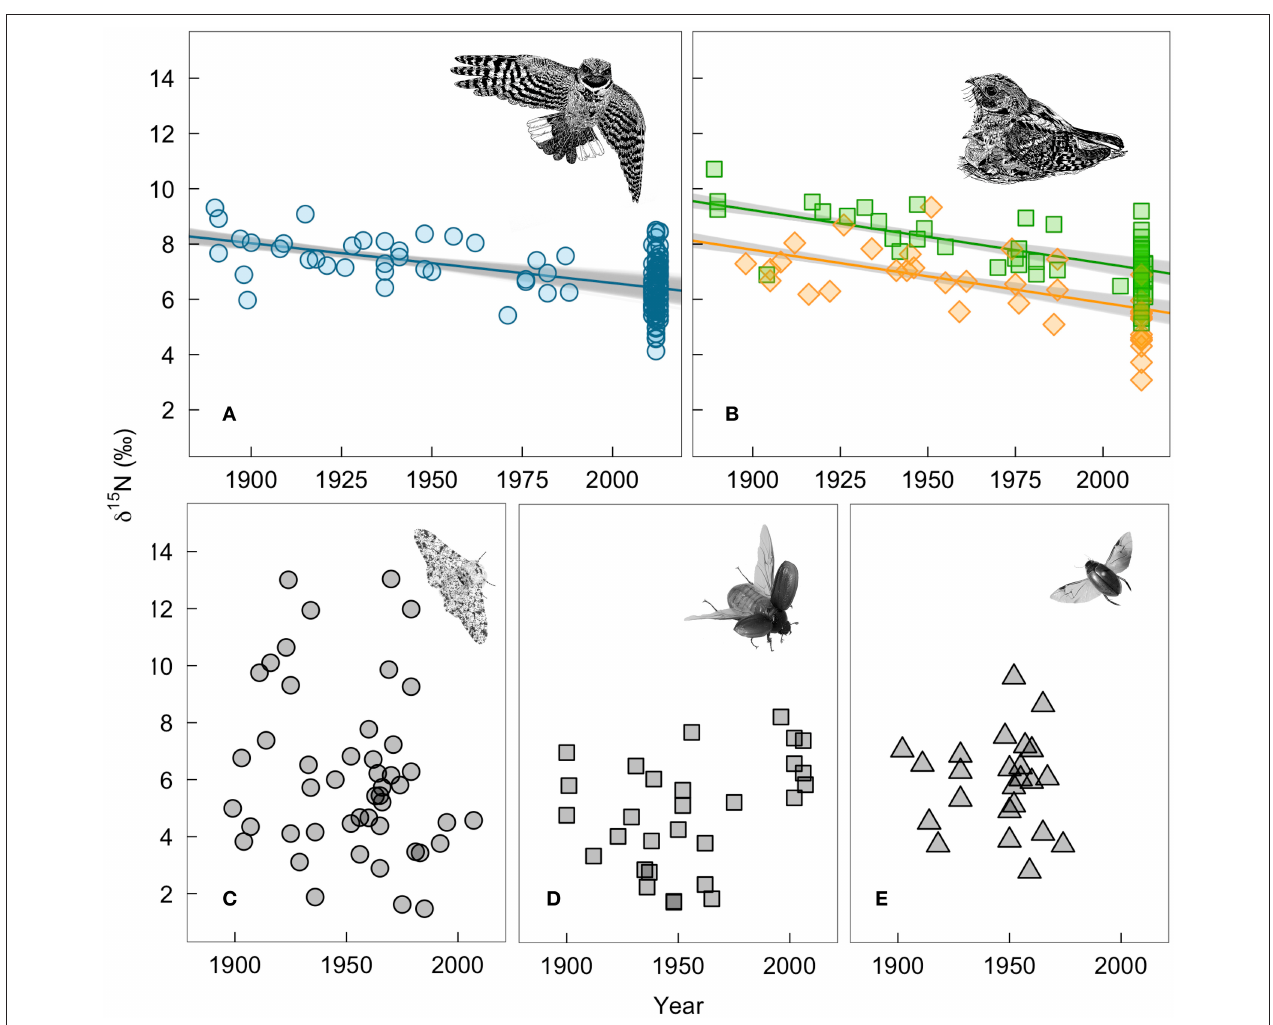
FIGURE 3 | Measured changes in δ 15 N- values of bird and insect tissues over time: (A) winter-grown A. vociferus claws, (B) A. vociferus feathers grown by adults on the breeding grounds (squares) or juveniles still being feed by parents (diamonds), (C) Biston betularia , (D) Phyllophaga anxia , and (E) Colymbetes sculptilis . The lines show the mean predicted relationship from linear models controlling for δ 13 C based on all historic samples and 1,000 bootstrapped sub-samples of contemporary bird tissues. The gray shows the variation in predicted slopes. Bird illustrations are courtesy of Marinde